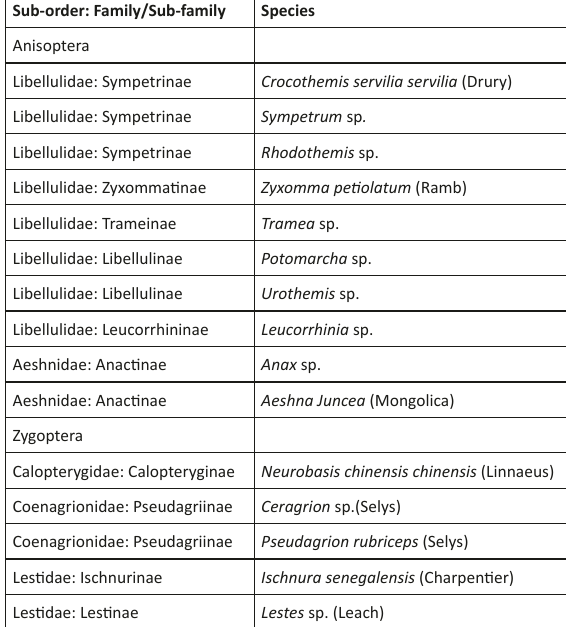
Table 1. Odonata larvae collected from KLNP, Manipur, northeastern India Sub-order: